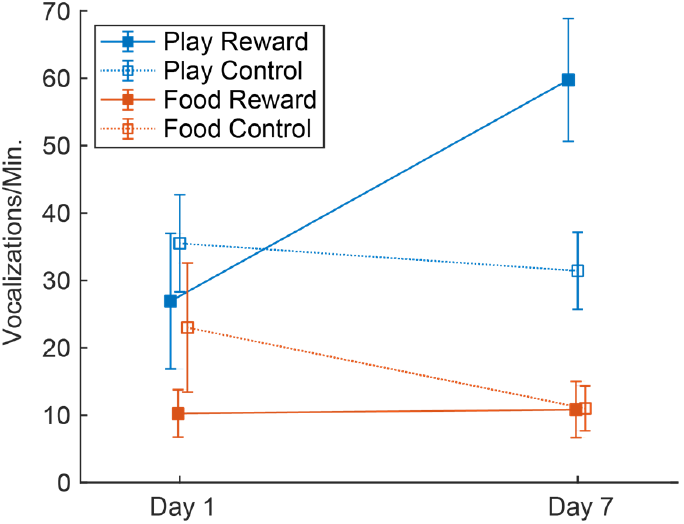
Figure 1. The average rate of 50 kHz vocalizations produced on day 1 and 7 of anticipatory testing. All error bars are standard error of the mean.